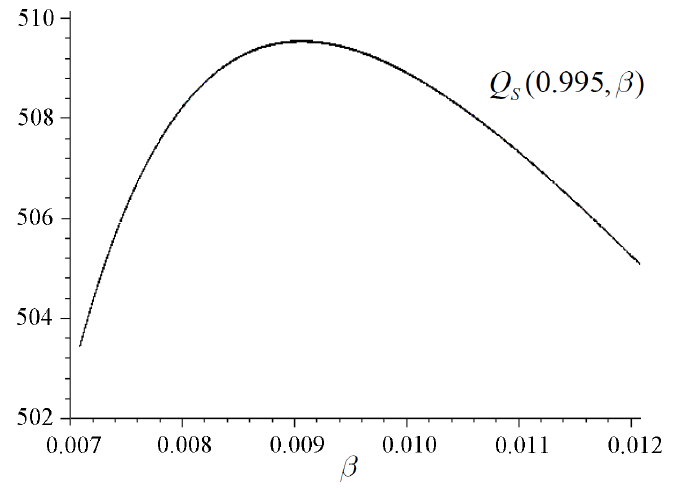
(0.995, β ) in Example S